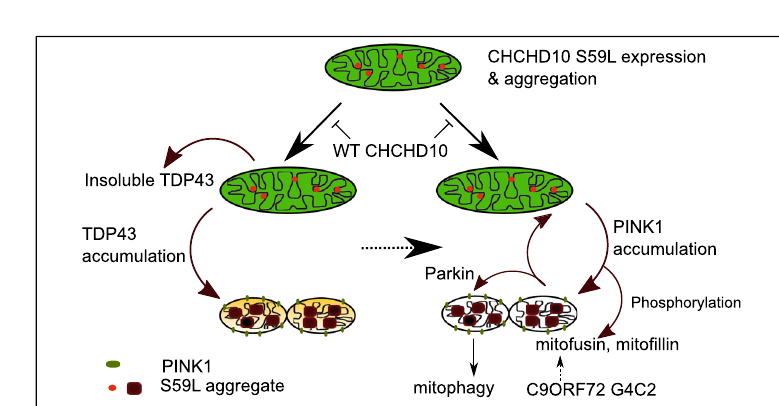
Fig. 9 Two axes of CHCHD10 S59L -induced toxicity. a CHCHD10 S59L can generate cellular toxicity with or without WT CHCHD10 and its close paralog CHCHD2. The toxicity of the gain-of-function CHCHD10 S59L mutant is mediated by two different pathways. TDP-43 axis: Upon CHCHD10 S59L expression, TDP-43 becomes more insoluble in the cytoplasm, probably due to mitochondria-induced stresses 56,57 and accumulates in mitochondria via increased binding with CHCHD10 S59L . The toxicity generated by mitochondrial TDP-43 can be mitigated by inhibitors for TDP-43 mitochondrial translocation. PINK1 axis: in response to CHCHD10 S59L expression, PINK1 is stabilized and accumulates on mitochondria in an uncontrolled manner. PINK1 phosphorylates its downstream targets, including mitofusin, mito fi lin, and Parkin, which results in signi fi cant mitochondrial fragmentation, maladaptive cristae formation, and excessive mitophagy. A positive feedback mechanism via PINK1 accumulation may accelerate these processes. Genetic or chemical modulation of this reduces CHCHD10 S59L -mediated cellular toxicity through both TDP-43 and PINK1